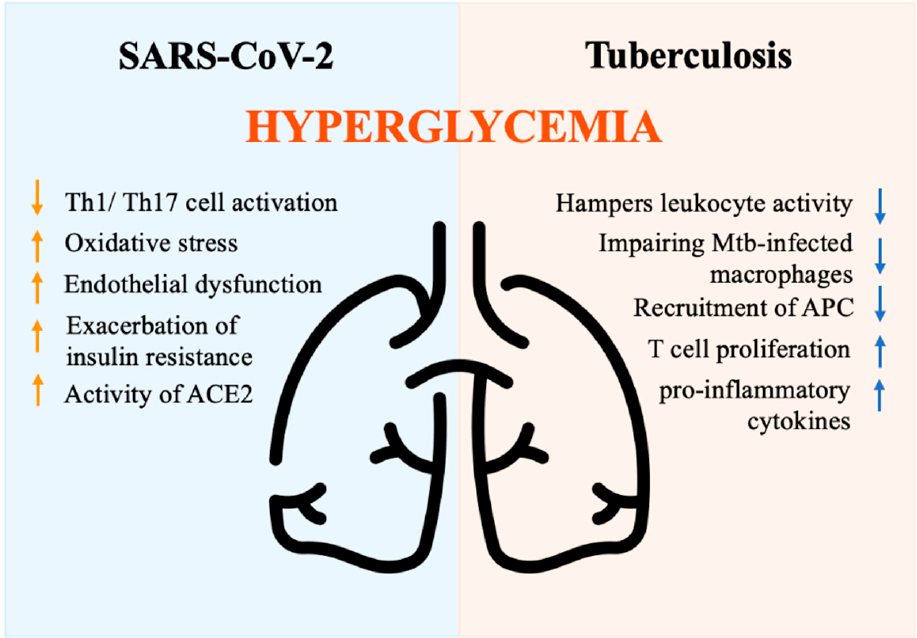
Figure 4. Immune response driven by hyperglycemia during SARS-CoV-2 and tuberculosis infections. Figure 4. mmune response driven by hyperglycemia during SARS-CoV-2 and tuberculosis ACE2 (Angiotensin-converting enzyme 2), APC (Antigen-presenting cells), Mtb ( Mycobacterium infections. ACE2 (Angiotensin-converting enzyme 2), APC (Antigen-presenting cells), Mtb tuberculosis bacilli), Th1/Th17 (Lymphocytes T helper 1 e 17), Icon design by ( Mycobacterium tuberculosis bacilli), Th1/Th17 (Lymphocytes T helper 1 e 17), Icon design by icons8